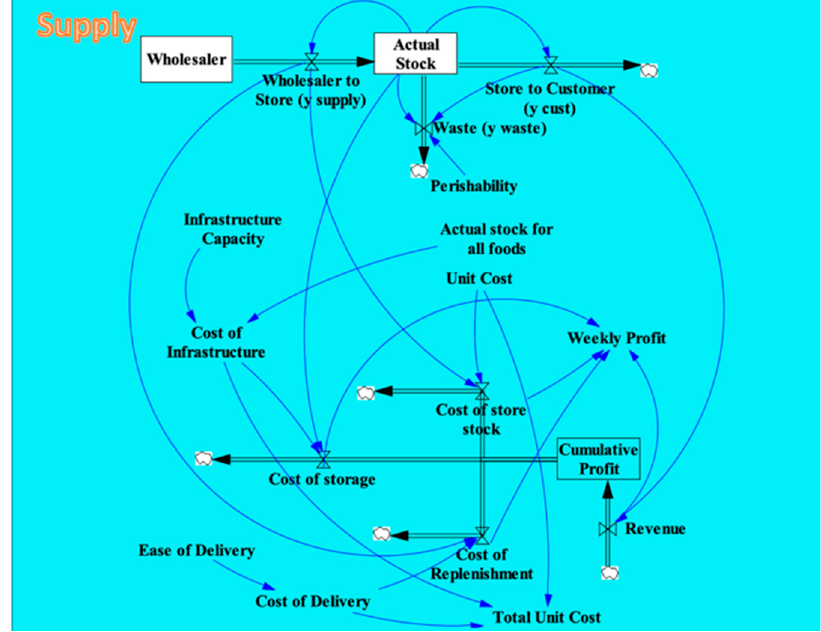
Figure 2. Variables and dependencies within the Retailer Dimension of the SFO Visual Model.